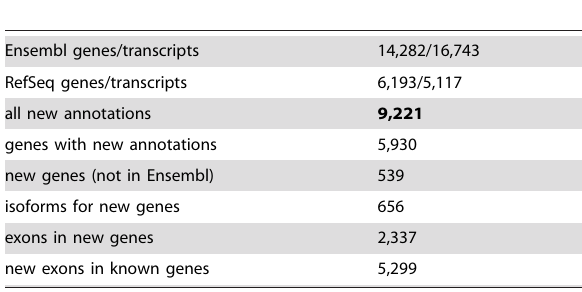
Table 2. New Isoforms and